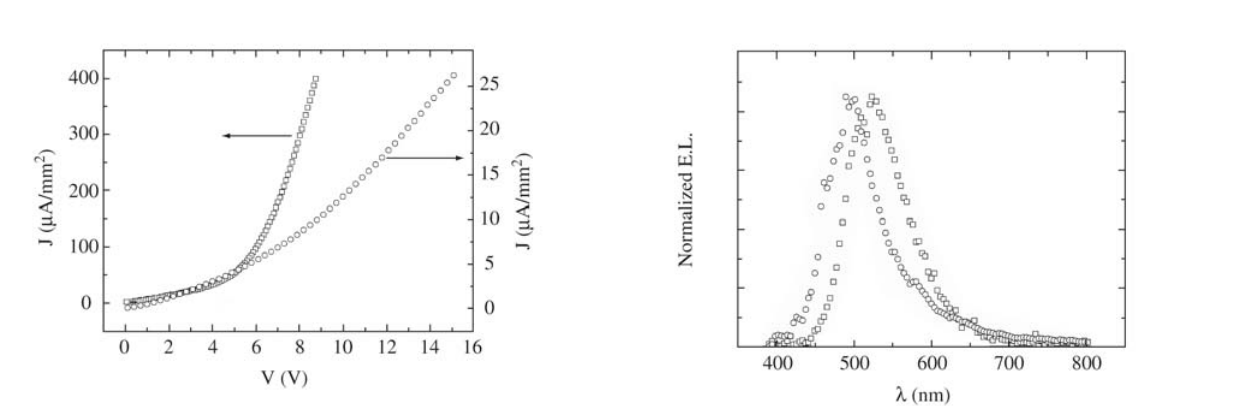
/Ca/Al, the left one 3